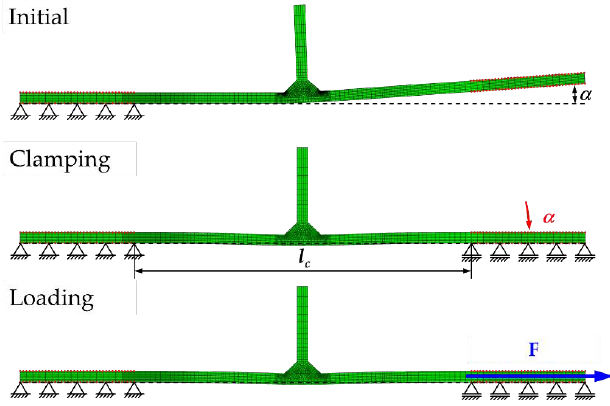
Figure 12. Simulation flow: straightening of the specimen due to clamping process and subsequent loading.